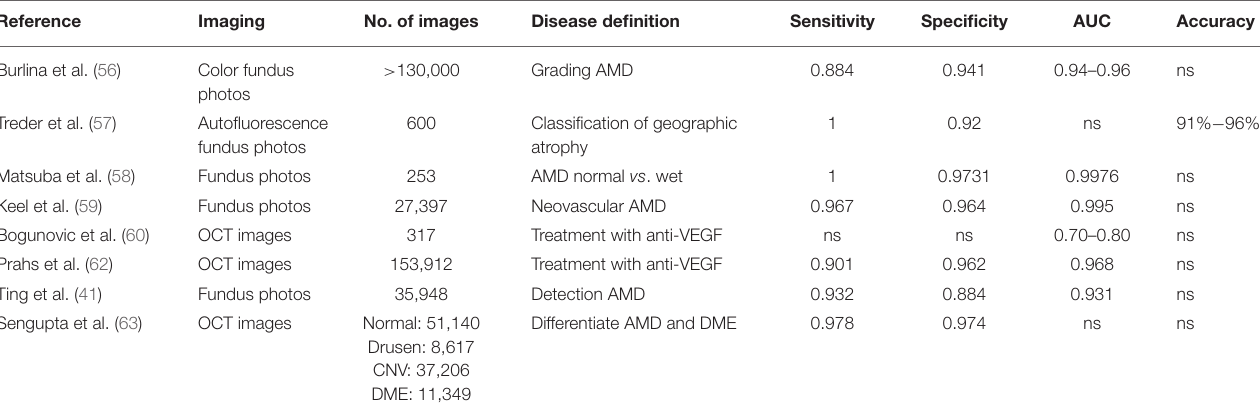
TABLE 3 | Summary of studies about AI and age-related macular degeneration.